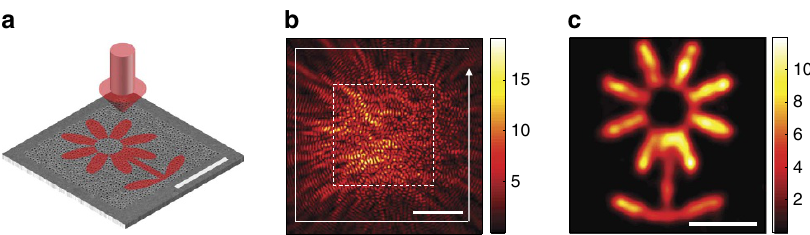
Figure 6 | Experimental demonstration of the delivery of a 2D far-field image to a 1D SPP sampling line. ( a ) A far-field illumination containing a flower pattern was projected to the patterned area on Au film. Scale bar, 5 m m. ( b ) Experimentally measured SPP map for the illumination of the flower pattern. The dashed white square indicates an area where the flower pattern was projected. SPPs were sampled along a white line forming a square of side length 17.3 m m. Colour bar: amplitude in an arbitrary unit. Scale bar, 5 m m. ( c ) Intensity map of the reconstructed image projected through the far-field illumination from the SPPs sampled along the white line in ( b ) Colour bar: intensity in an arbitrary unit. Scale bar, 2